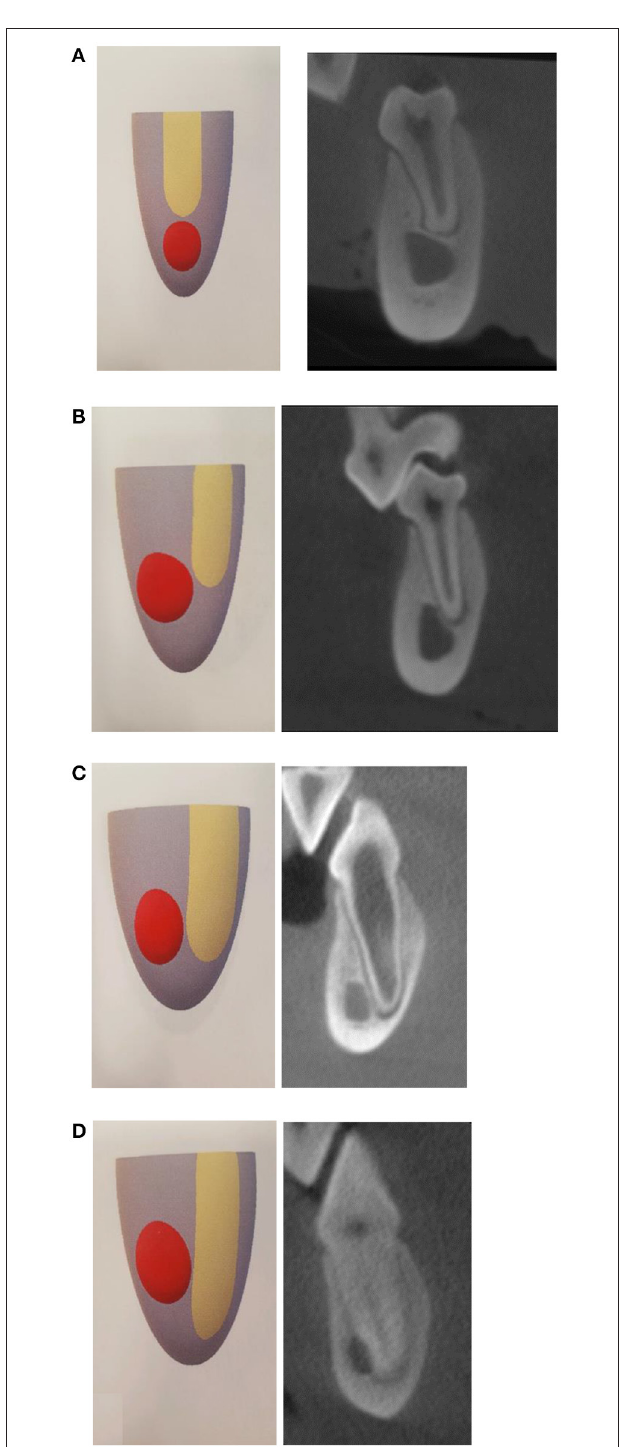
FIGURE 1 | Apical positioning relative to the mandibular canal is classified as four different locations. (A) Apical position 0 is described as the apex terminating dorsal to the mandibular canal. (B) Apical position 1 is described as apices extending or contacting up to 50% the height of the mandibular canal. (C) Apical position 2 includes apices extending > 50% the height of the mandibular canal but not extending ventral to the mandibular canal. (D) Apical position 3 is described as apices that extend ventral to the mandibular